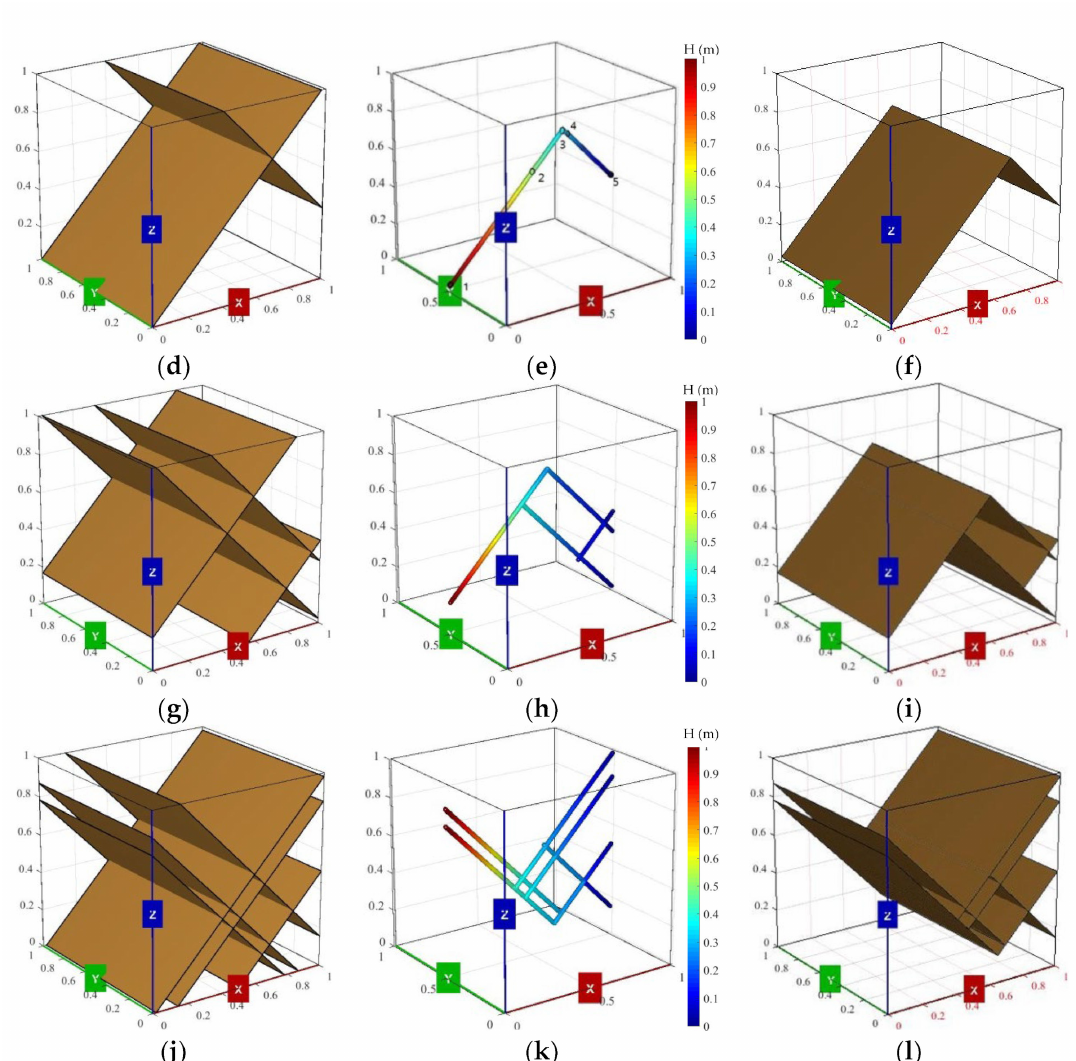
Figure 3. DFN models, EPN models, and simplified DFN models. ( a ) The DFN model with one fracture; ( b ) The EPN model extracted from Figure 3a; ( c ) The simplified DFN model extracted from Figure 3a; ( d ) The DFN model with two fractures; ( e ) The EPN model extracted from Figure 3d; ( f ) The simplified DFN model extracted from Figure 3d; ( g ) The DFN model with four fractures; ( h ) The EPN model extracted from Figure 3g; ( i ) The simplified DFN model extracted from Figure 3g; ( j ) The DFN model with six fractures; ( k ) The EPN model extracted from Figure 3j; ( l ) The simplified DFN model extracted from Figure